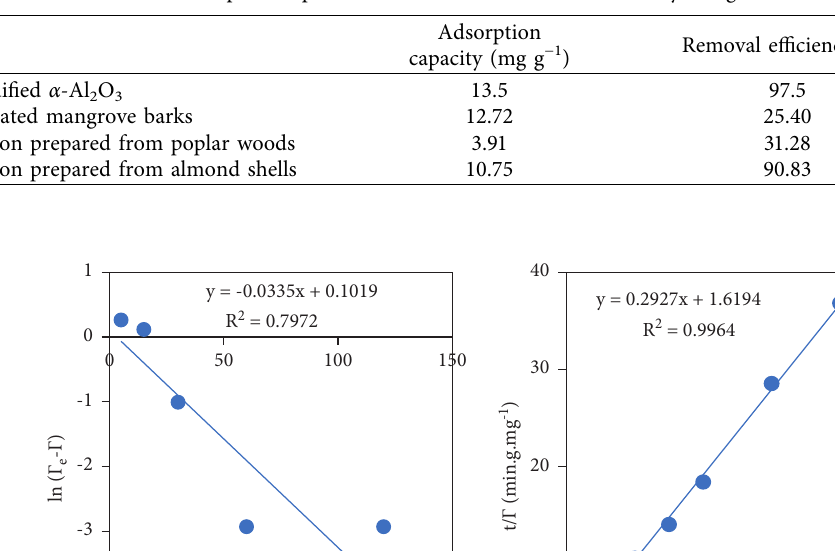
Table 1: NCC adsorption capacities and NCC removal efficiencies by using different adsorbents.